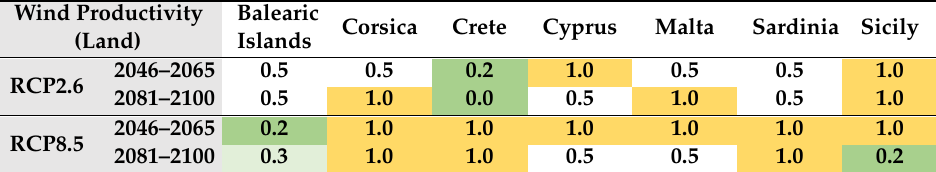
Table A1. Normalized uncertainty (Nu) for wind productivity for each island, scenario and time period. Deep yellow: Nu = 0.8–1. Nu is computed over land.